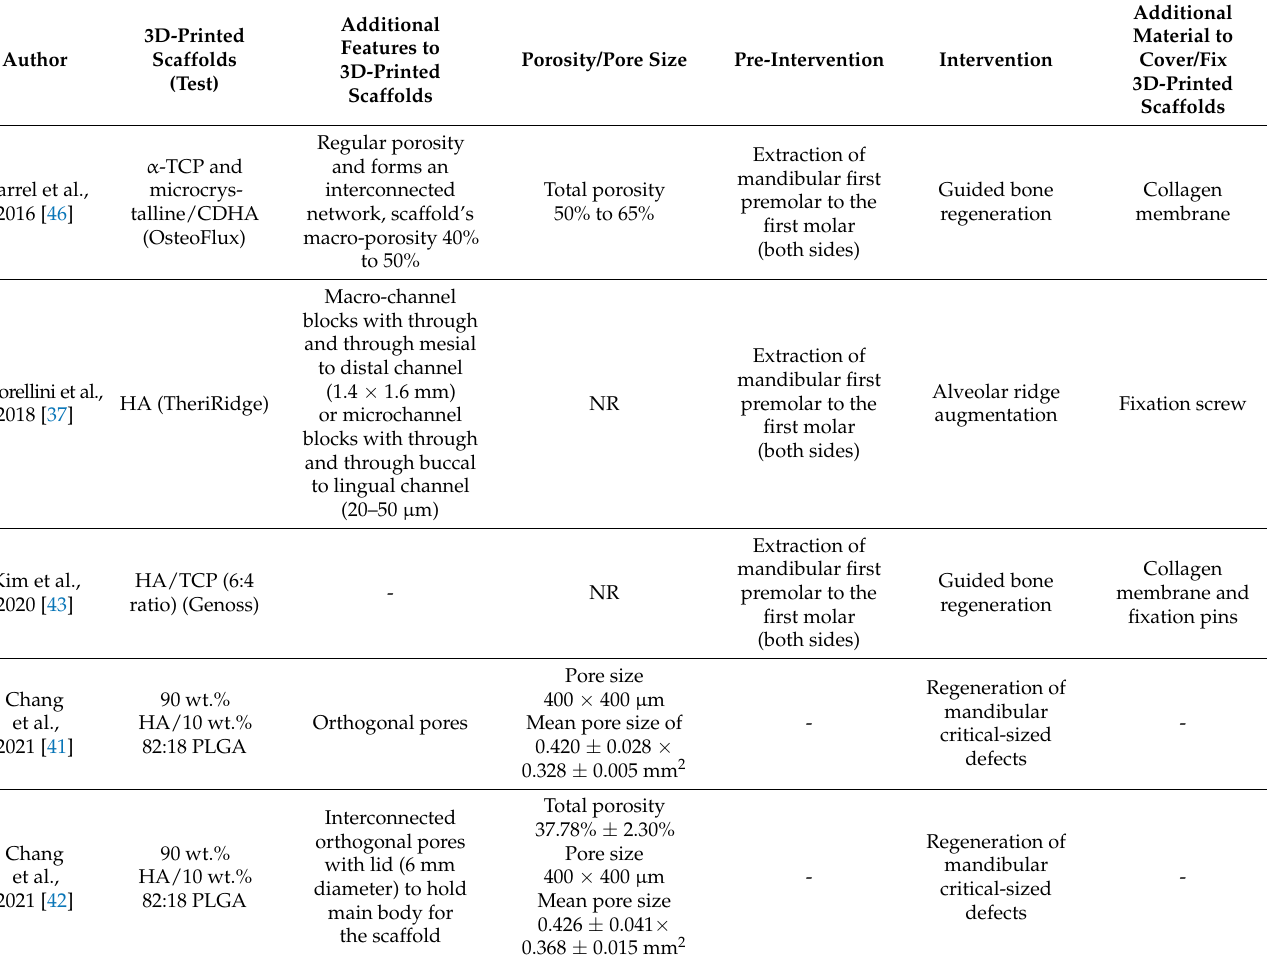
Table 4. The characteristics of 3D-printed HA- and TCP-based bone scaffolds and study